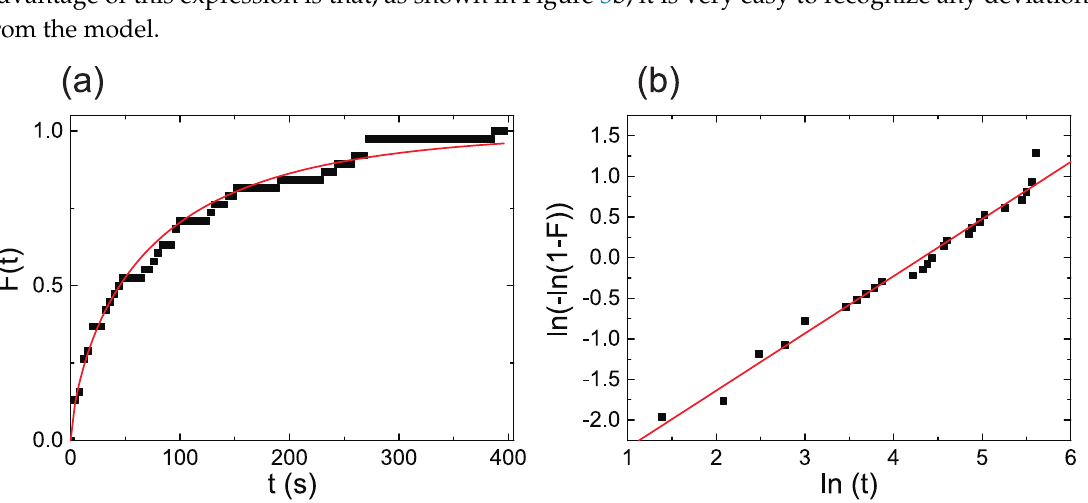
Figure 3. ( a ) Weibull cumulative function measured for a voltage level of 3.2 V with the structure W. The red line is a fit to Equation (2); ( b ) Weibull plot showing the linear behavior expected from Equation (4). The red line is a linear